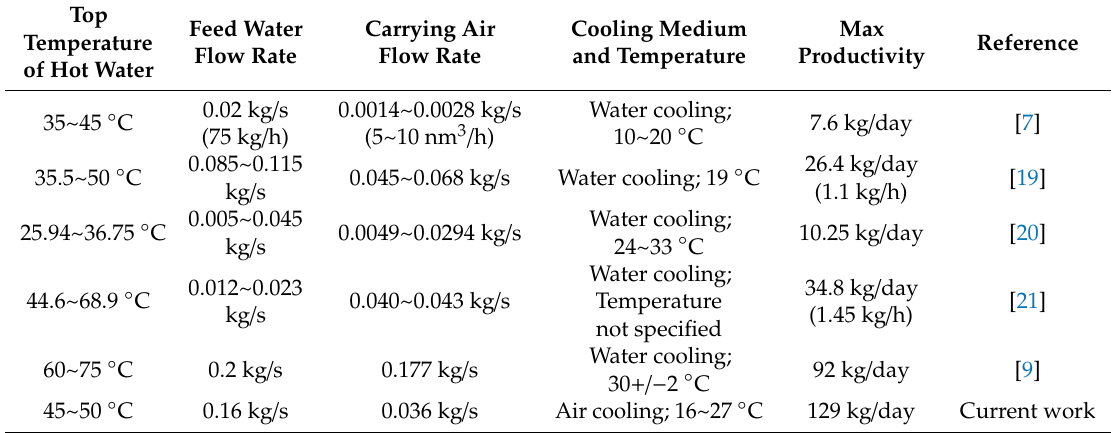
Table 1. Selected previous work on HDH systems.